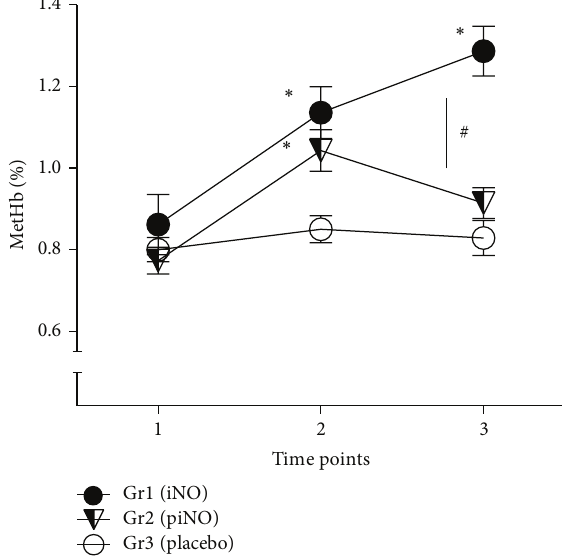
Figure 4: There was a significant increase in methemoglobin levels comparedwithbaselinefortheiNOtreatedpatientsandasignificant difference over time in contrast to the placebo treated ( ∗ 𝑃 < 0.05 ); also, a significant difference between the two iNO groups was observed ( # 𝑃 < 0.05 ). Groups 1 (iNO) and 3 (placebo, N 2 ) received iNO 80 ppm or placebo throughout the entire operation, whereas group 2 (piNO) only received iNO 80 ppm in the beginning and at the end of the operation. Time point 1; before the spinal anesthesia, time point 2; before tourniquet activation, and time point 3; after tourniquet release. Mean ±